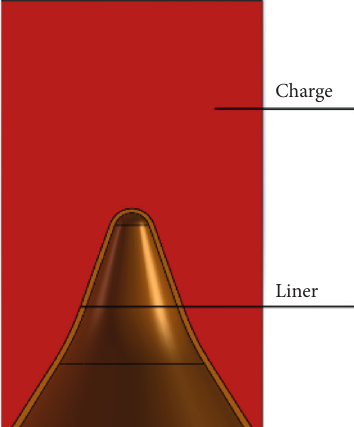
Figure 1: Warhead structure.